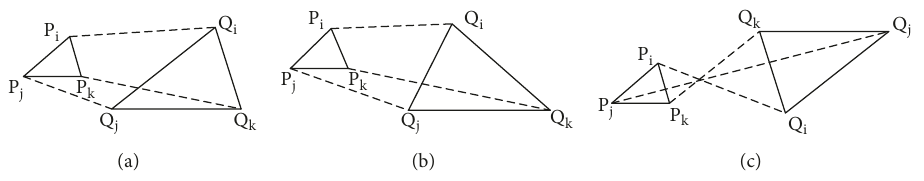
Figure 4: Similar triangle